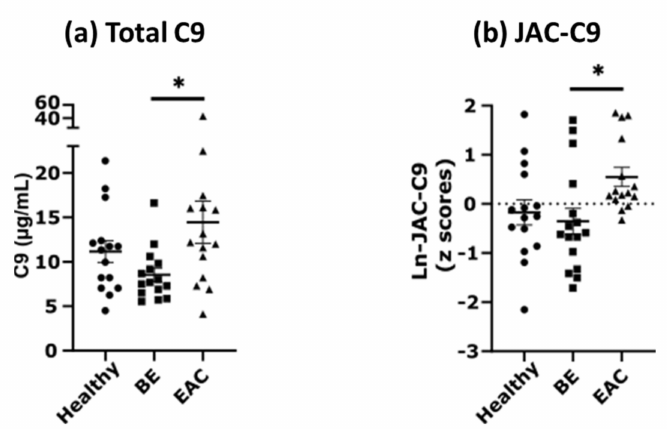
Figure 4. Serum C9 and JAC-C9 are increased in EAC in a cohort of 46 samples. ( a ) Serum C9 concentration was determined using direct ELISA with m26 3C9 antibody. Patients diagnosed with EAC show significantly increased C9 concentration relative to BE (one-way ANOVA with Tukey’s multiple comparisons, p = 0.0323). ( b ) JAC-C9 was determined using EndoScreen Chip. Patients diagnosed with EAC show significantly increased JAC-C9 relative to BE (one-way ANOVA with Tukey’s multiple comparisons, p = 0.0279). *, p <